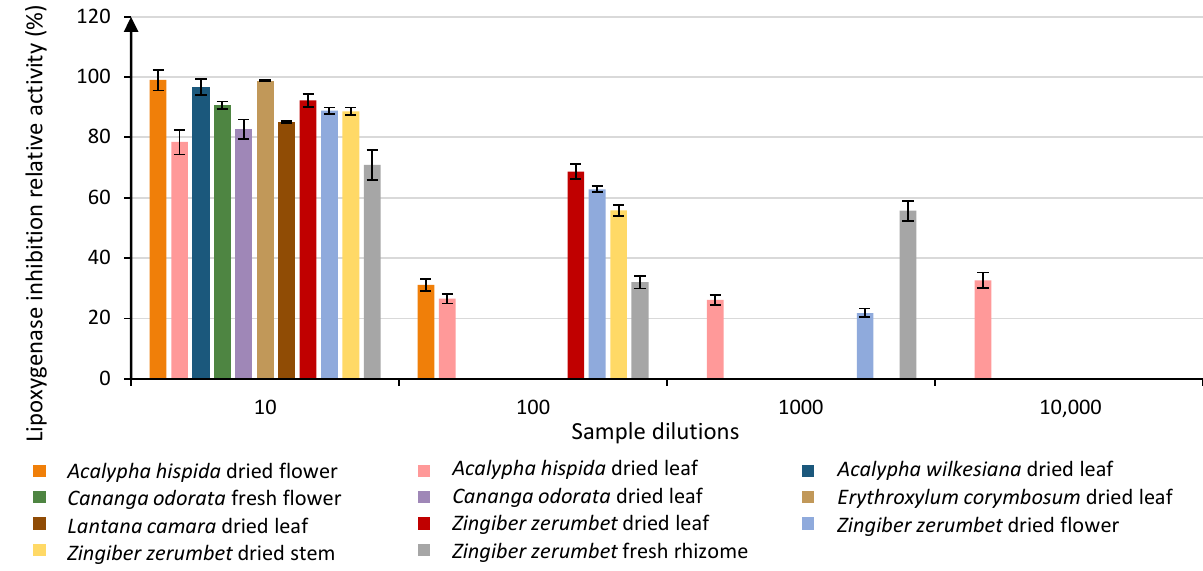
Figure 1. Evolution of the relative lipoxygenase inhibition activity of the most efficient plant extract samples through 4 different dilutions (10, 100, 1000 and 10,000). Each column represents the mean ± SD ( n = 3) per sample.